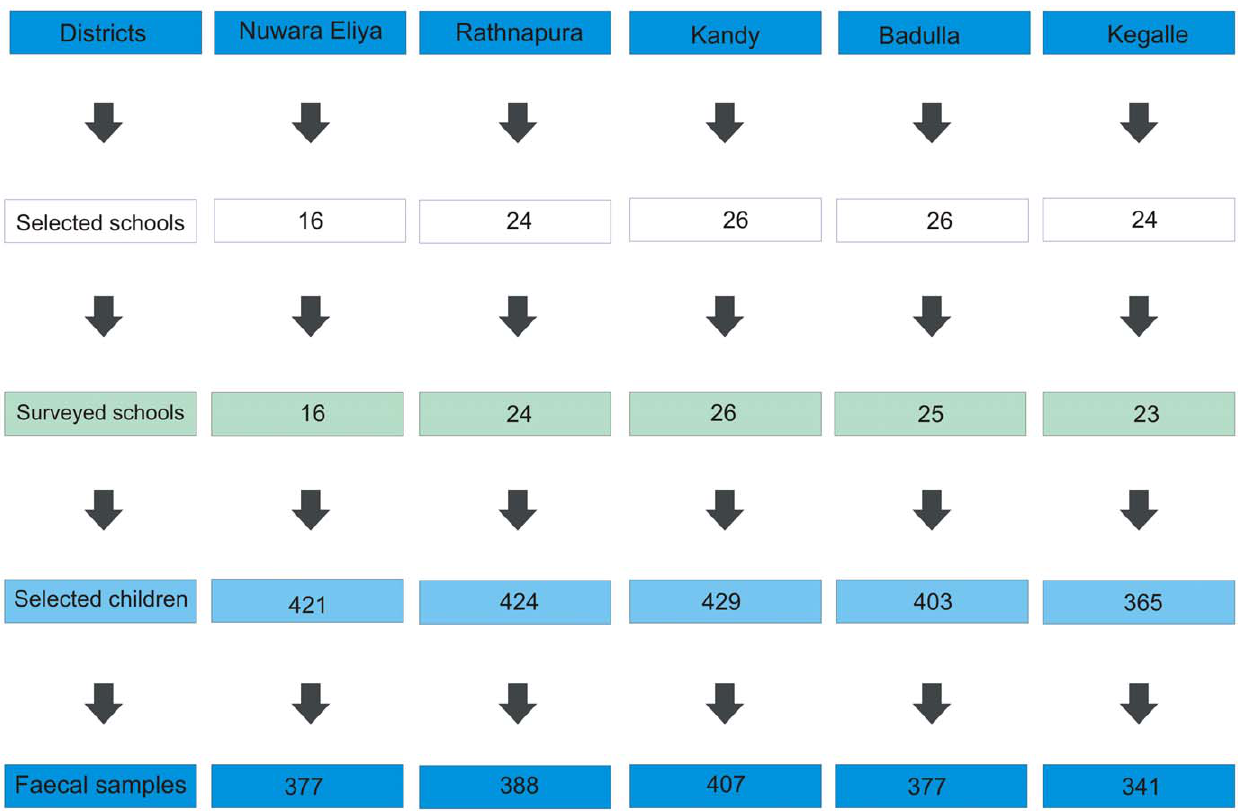
Figure 2. Flow chart showing numbers of selected schools, surveyed schools, selected children and faecal samples obtained in each district.